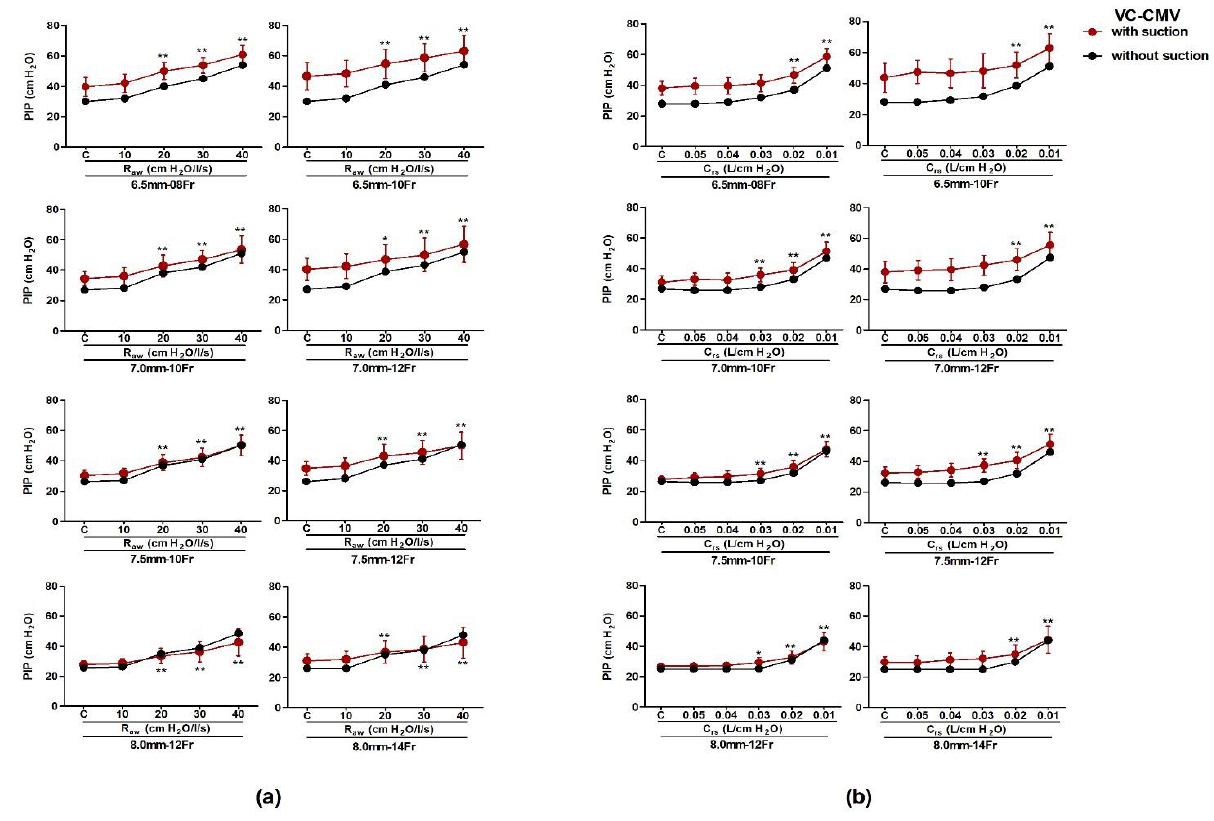
Figure 2. Comparison of the change of PIP effects in VC-CMV undergoing closed endotracheal suction: ( a ) Change of airway resistance and ( b ) lung compliance of pulmonary mechanics in various ETTs paired with SCs of CSS. C: control (0.08 L cm H 2 O − 1 of C rs and 5 cm H 2 O L − 1 · s of R aw ) group. VC-CMV: volume control continuous mandatory ventilation, this mode is set to V T 0.6 L with peak flow 60 Lpm; PIP: peak inspiratory pressure; R aw : airway resistance; C rs : lung compliance; ETT: endotracheal tube; SC: suction catheter; 6.5 mm − 08 Fr: 6.5 mm ETT paired with 08 Fr SC, and so on. The closed suctioning procedure was repeated three times. The error bars represent the standard deviation of 30 breaths in each of the pulmonary mechanic scenarios (five airway resistance levels and six lung compliance levels). The independent samples t -test was used to compare with the control group. * p < 0.05, ** p <